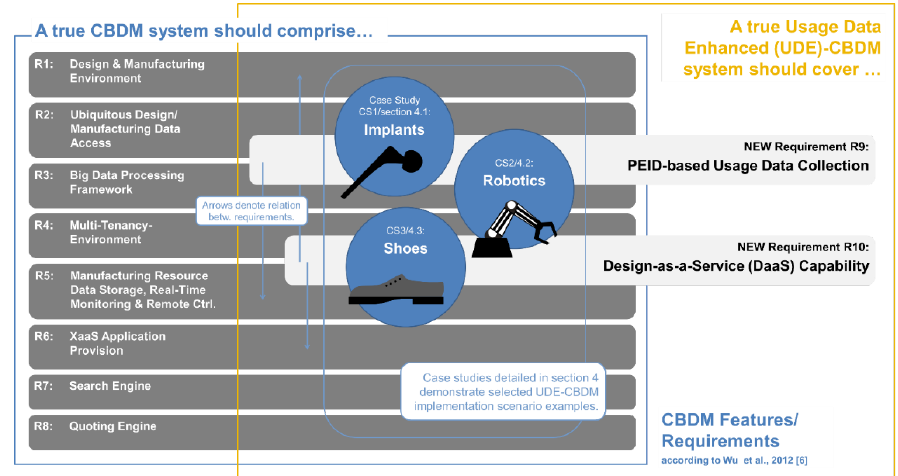
Figure 2. Requirements or criteria which characterize a CBDM approach, and additional ones which constitute its extension to Usage Data-enhanced (UDE)-CBDM.